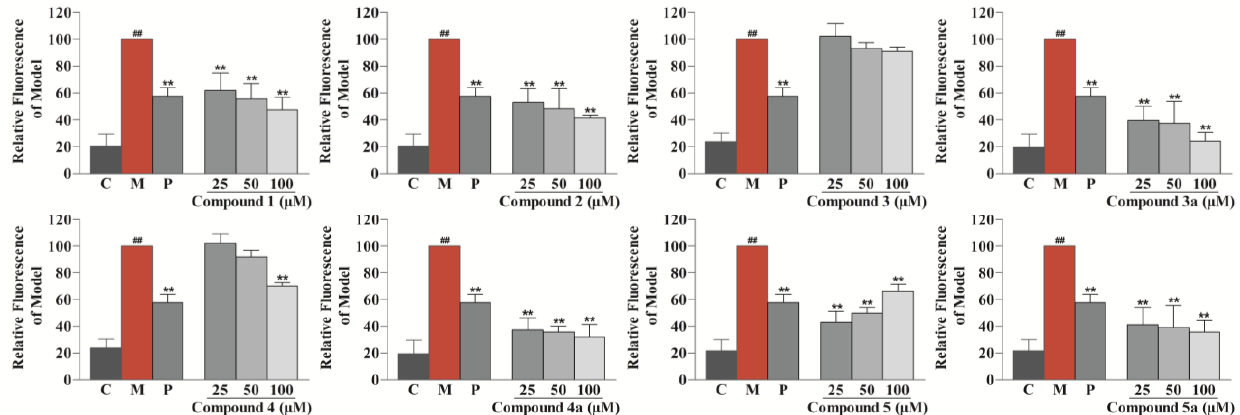
Figure 5. Effects of compounds 1 – 5 and 3a – 5a to inhibit lipid drops accumulation in ox-LDL-treated RAW264.7 cells determined by Nile Red staining. Results are expressed as the mean ± SD ( n = 3). Model group was subject to 75 μg/mL ox-LDL. Positive group was subject to 25 μM simvastatin. ## p < 0.01 vs. control group; ** p < 0.01 vs. model group. C: control group, M: model group, and P: positive group.